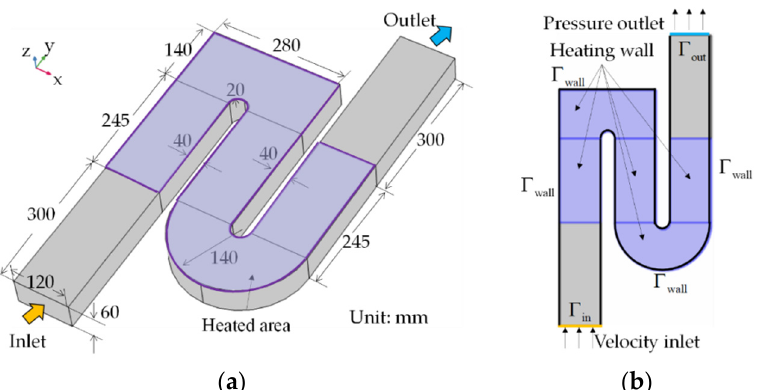
Figure 1. Numerical model of a three ‐ short ‐ pass serpentine channel: ( a ) full 3D model; ( b ) 2D simplified design from the 3D model.